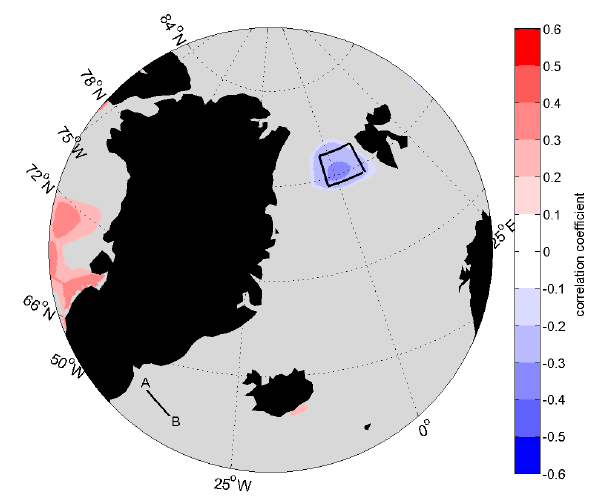
Fig. 8. Map of the time-lagged correlation coefficient between an 11 year time series (1994 to 2004) of the OCCAM sill salinity anomaly time series shown in Fig. 5b, and a 1994 to 2004 time series of CMAP 5 day mean precipitation (extracted from OCCAM) (p < 0.01). Time lag is 7 years. Grey indicates no statistically significant correlation. Boxed area indicates region of passive tracer release.